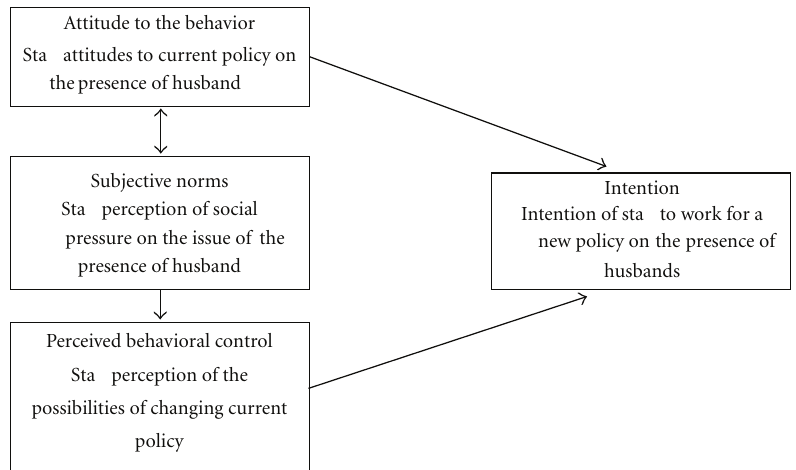
Figure 1: The Study’s theoretical model derived from the Ajzen and Madden theory of reasoned